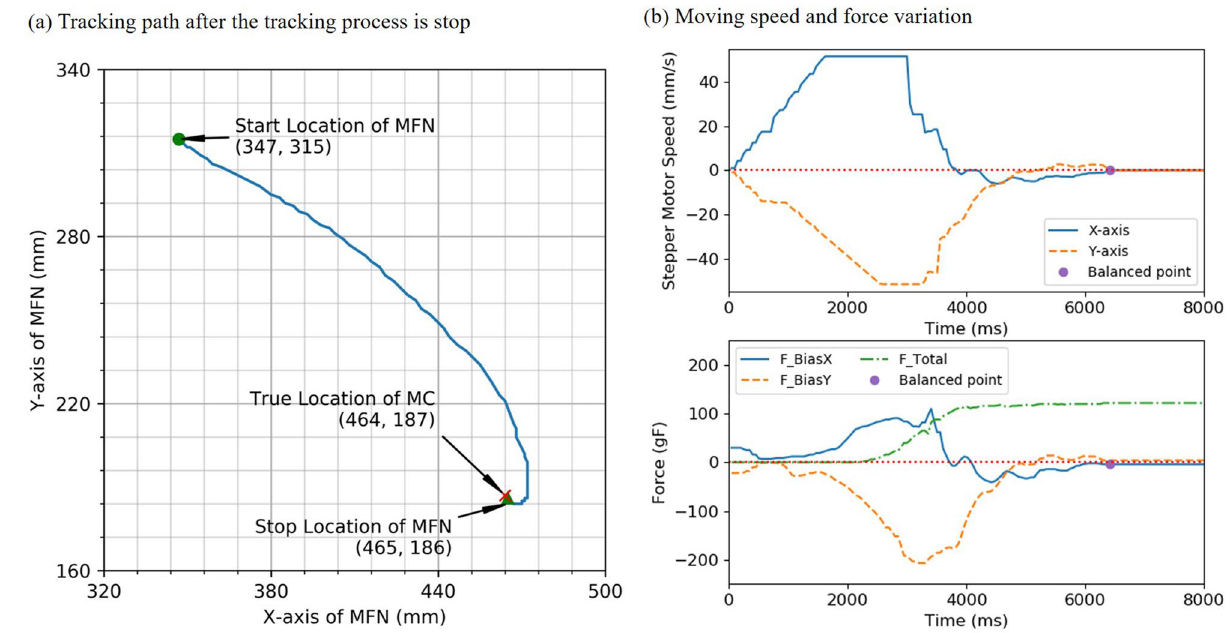
Figure 3. Illustration of the trace, moving speed and force variation in localization function. ( a ) The tracking path illustrates a localization trace after the tracking process is stopped. The starting point of EPM was placed at (x = 347, y = 315), and the IPM was placed at (x = 464, y = 187) with a vertical height difference of 7.5 cm. ( b ) The variation in motor speed and force vectors are presented.